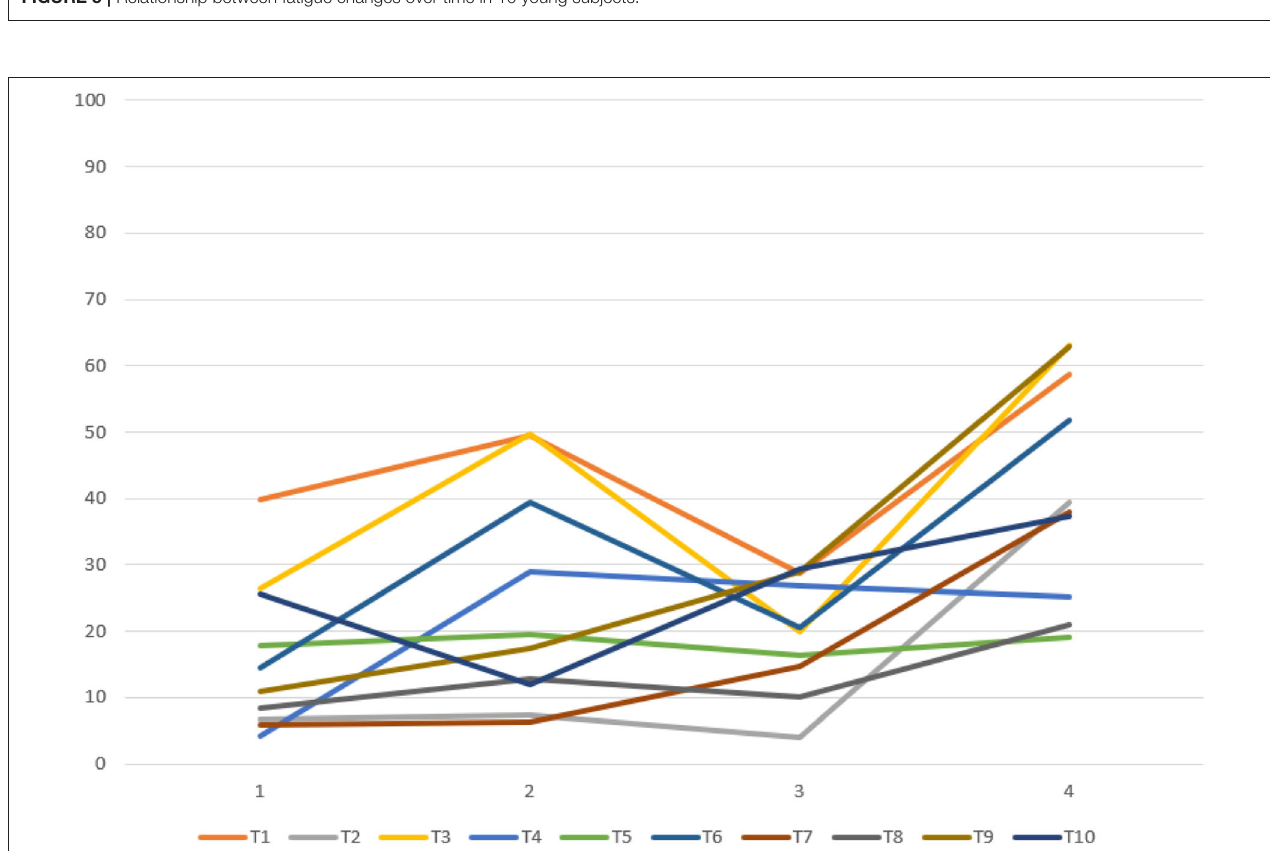
FIGURE 6 | Relationship between fatigue changes over time in 10 elderly subjects.